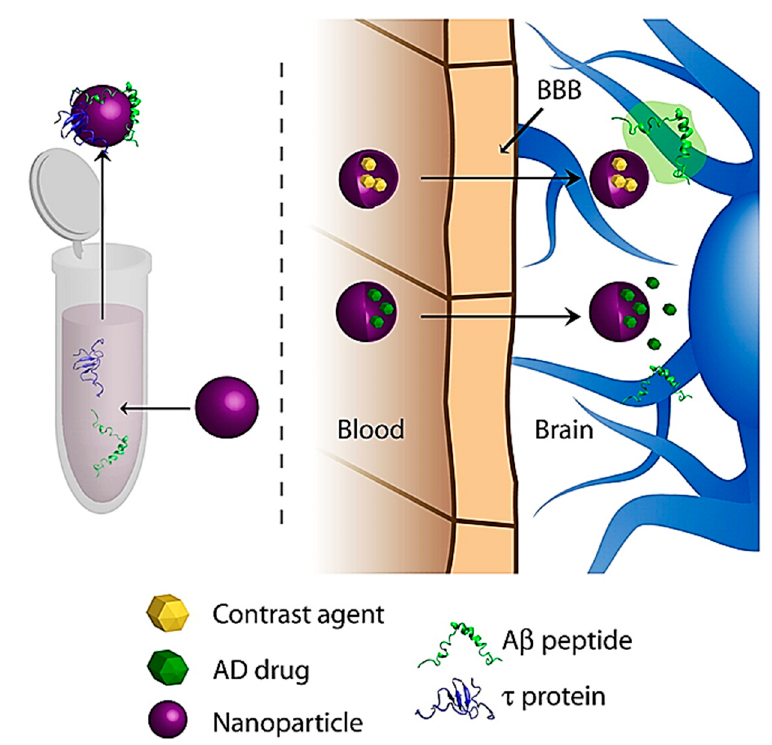
Figure 9. General schematic of NP diagnostic approaches for AD. Reproduced from [142], with permission from Elsevier,